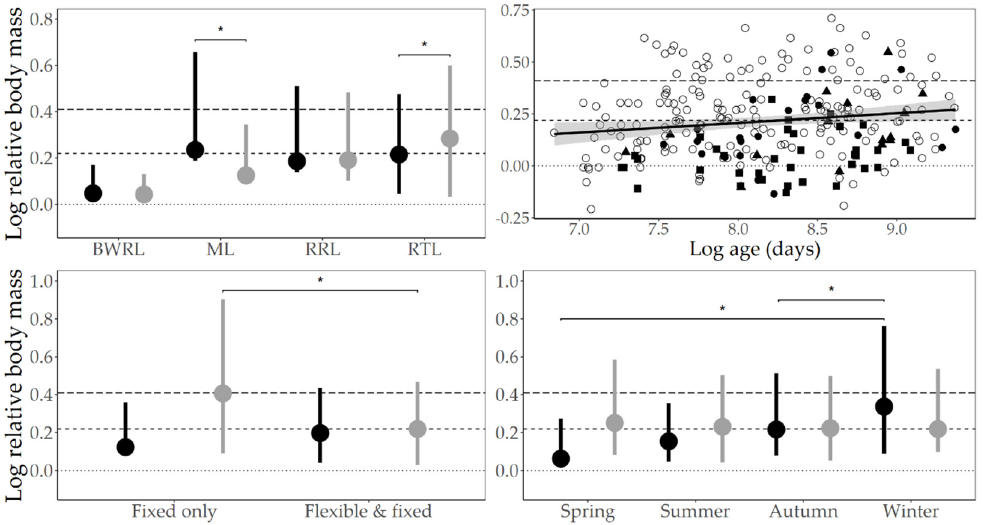
Figure 5. Relationships between relative body mass and species × sex, age, climbing structure provision × sex, and season × sex. Dotted horizontal line indicates the point at which relative body mass = 1 (i.e., the captive animal is the same weight as its species-typical wild mean; 0 on the log-scale); the short dashed line indicates the overweight threshold ( ≥ 1.25, or 0.22 on the log-scale); and the long dashed line indicates the obese threshold ( ≥ 1.5, or 0.41 on the log-scale). On the three plots with error bars, points indicate the mean relative body mass value, and the whiskers the upper and lower 95% confidence intervals; differences between groups are indicated with asterisks; and females are indicated by black, males by grey. Top Left : BWRL: black-and-white ruffed lemur. ML: mongoose lemur. RRL: red ruffed lemur. RTL: ring-tailed lemur. Male mongoose lemurs have smaller relative body masses than females ( t 6 = − 2.76, p = 0.03), whereas male ring-tailed lemurs have larger values than females ( t 127 = 3.15, p < 0.01). Top Right : Relative body mass increases with age ( t 157 = 2.09, p = 0.04) across four lemur species (both log-transformed): black-and-white ruffed lemur = filled square; mongoose lemur = filled triangle; red ruffed lemur = filled circle; ring-tailed lemur = unfilled circle. The shaded area shows the 95% confidence region. Bottom Left : Males housed in enclosures featuring fixed climbing structures only (versus flexible and fixed structures) have larger relative body mass values ( t 157 = 3.04, p < 0.01). Bottom Right : Females weighed in the winter had larger relative body masses than those weighed in spring ( t 178 = 3.30, p < 0.01) and summer ( t 25 = 3.70, p < 0.01).